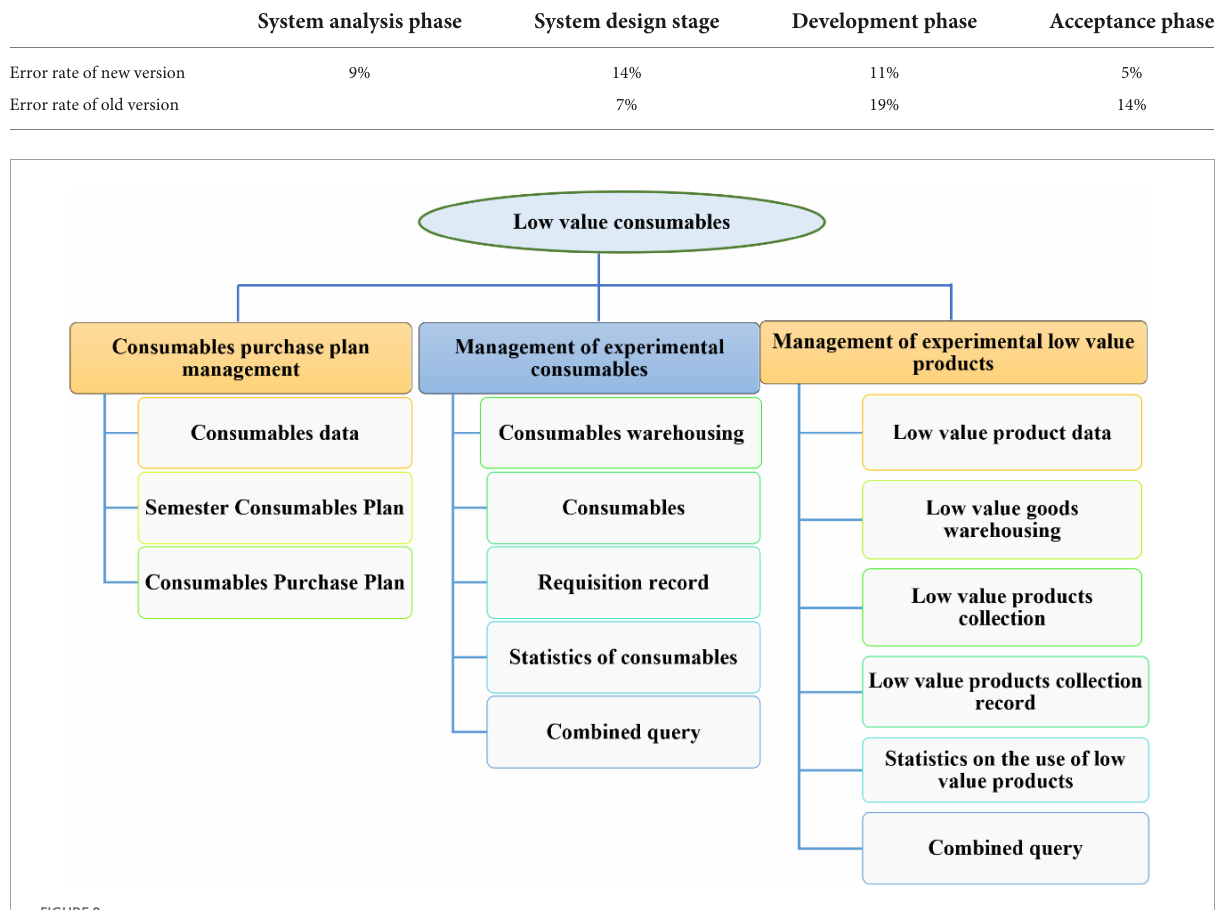
FIGURE9 Teaching management system (laboratory